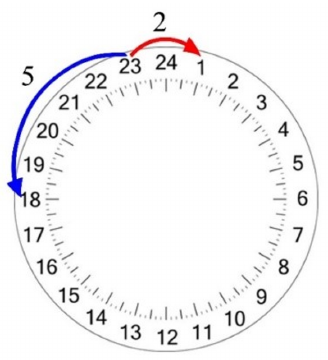
Figure 3. Description of distance based on